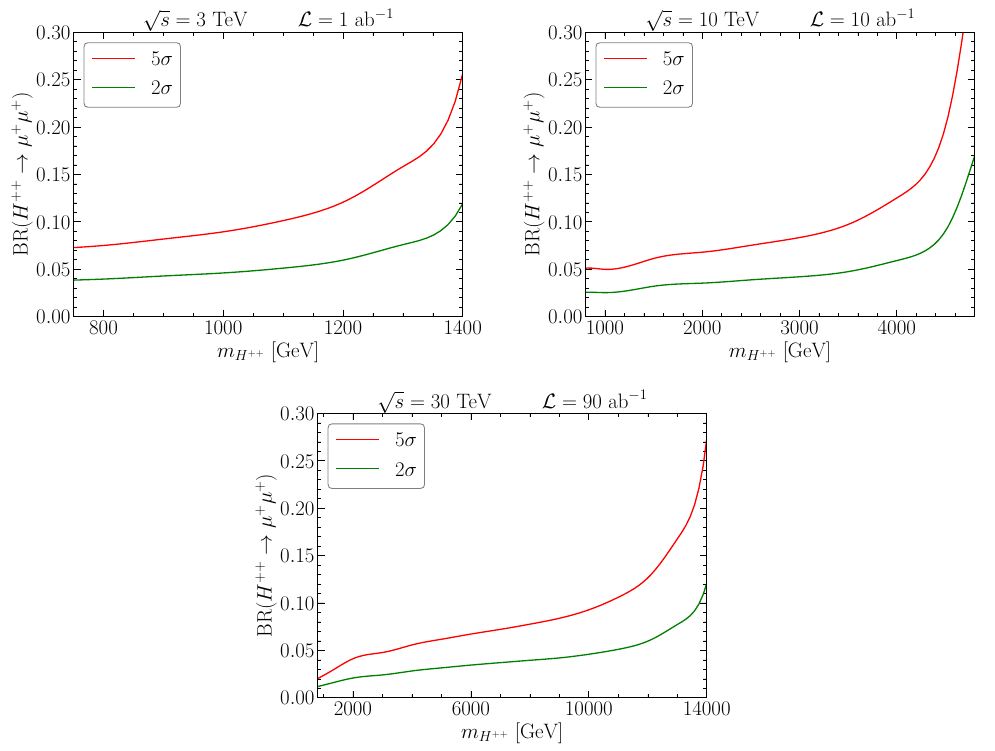
Figure 12 . The reachable branching ratios of H ++ → µ + µ + corresponding to 2 σ (green) and 5 σ (red) significance versus m for H ++ H −− → µ + µ + µ − µ − at muon colliders with H ++ ( L = 1 ab − 1 ), 10 TeV ( L = 10 ab − 1 ) and 30 TeV ( L = 90 ab − 1